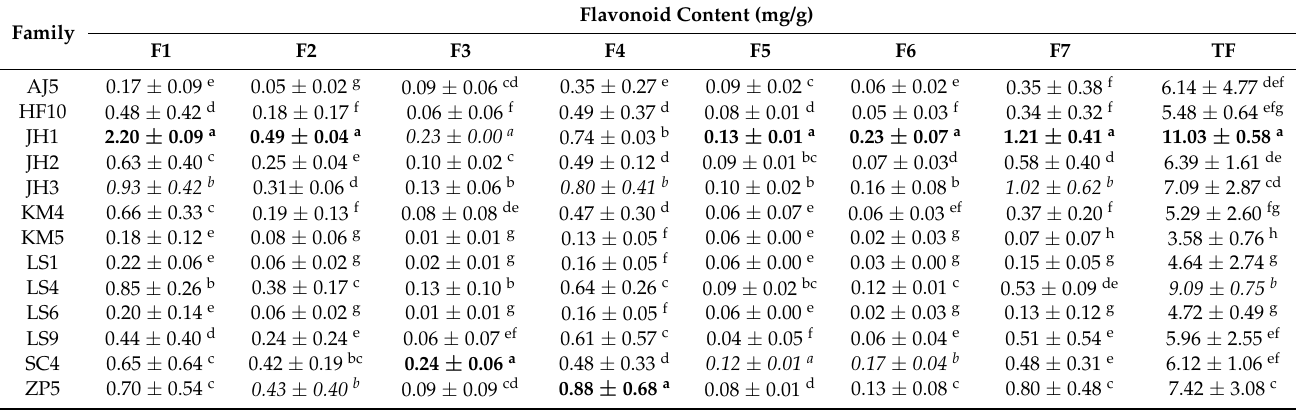
Table 2. Mean flavonoid contents in the leaves of 13 C. paliurus genotypes across two test sites. Flavonoid Content (mg/g) Family